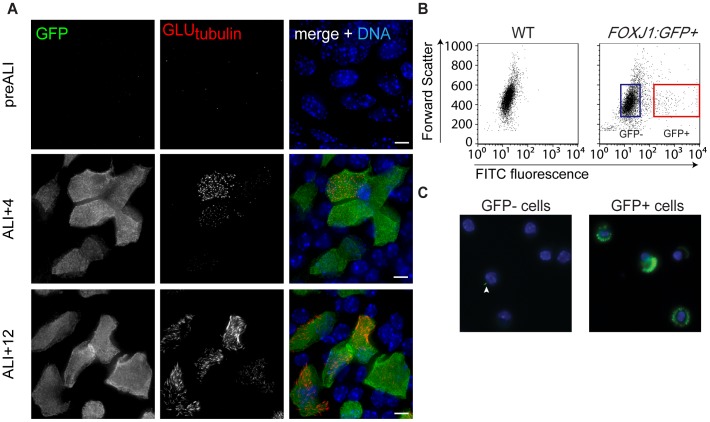
Microarray analysis of ciliating mouse tracheal epithelial cells. (A) Immunofluorescence staining showing representative images of GFP expression and ciliogenesis in FOXJ1:GFP MTEC cultures before establishment of the air-liquid interface (pre-ALI), at 4 days after ALI (ALI+4) and at 12 days after ALI (ALI+12). MTEC cultures were stained with antibodies against GFP, against glutamylated tubulin to mark cilia and basal bodies, and with DAPI to mark nuclei. GFP is expressed from the FOXJ1 promoter early during ciliogenesis, but is not expressed pre-ALI. At ALI+4, most FOXJ1:GFP+ cells are undergoing centriole formation but have not formed cilia. At ALI+12, most FOXJ1:GFP+ cells are forming cilia or have completed ciliogenesis. Scale bars, 5 µm. (B) FACS analysis of cells dissociated from a trachea from a wild type mouse (left panel) and a trachea from a FOXJ1:GFP-expressing mouse (right panel). The red and blue rectangles are representative gates used to sort GFP+ and GFP- populations, respectively. (C) Sorted cell populations were stained with DAPI (blue) and combined acetylated alpha-tubulin and gamma-tubulin antibodies (green) to detect cilia and basal bodies. After sorting, 90–95% of cells in the GFP+ population at ALI+12 had observable cilia and or amplified basal bodies, whereas <1% of cells in the GFP- population stained positive for these markers, although some had a single primary cilium (arrowhead).